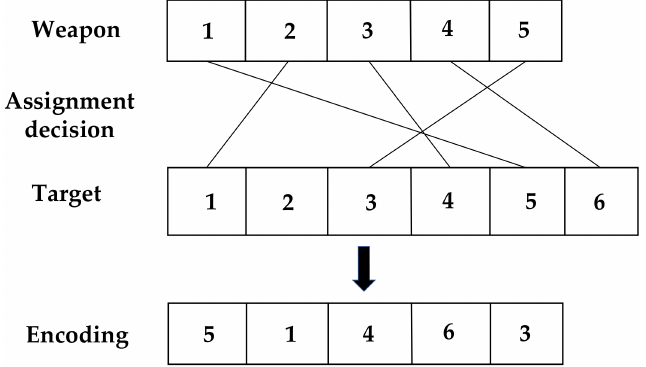
Figure 4. Encoding scheme of DWTA